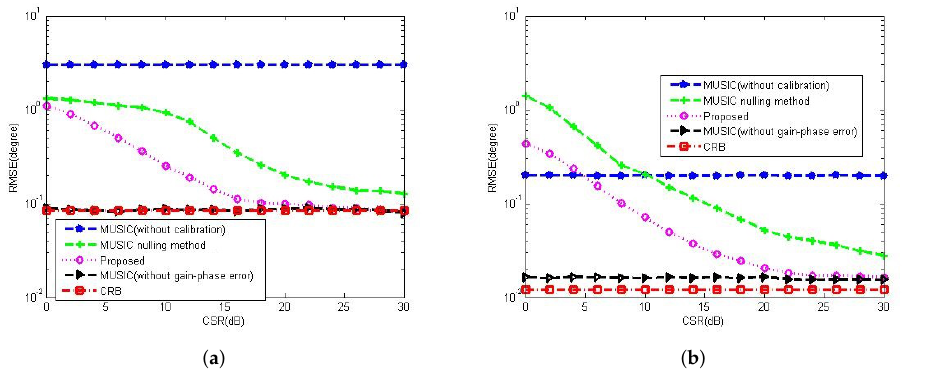
Figure 11. DOA estimation performance with different CSRs, SNR = 20 dB, K 0 = 20, T = 80, N = 40, T 0 = 40. ( a ) In 5-element ULA with deterministic gain-phase errors. ( b ) In 16-element ULA with random gain-phase